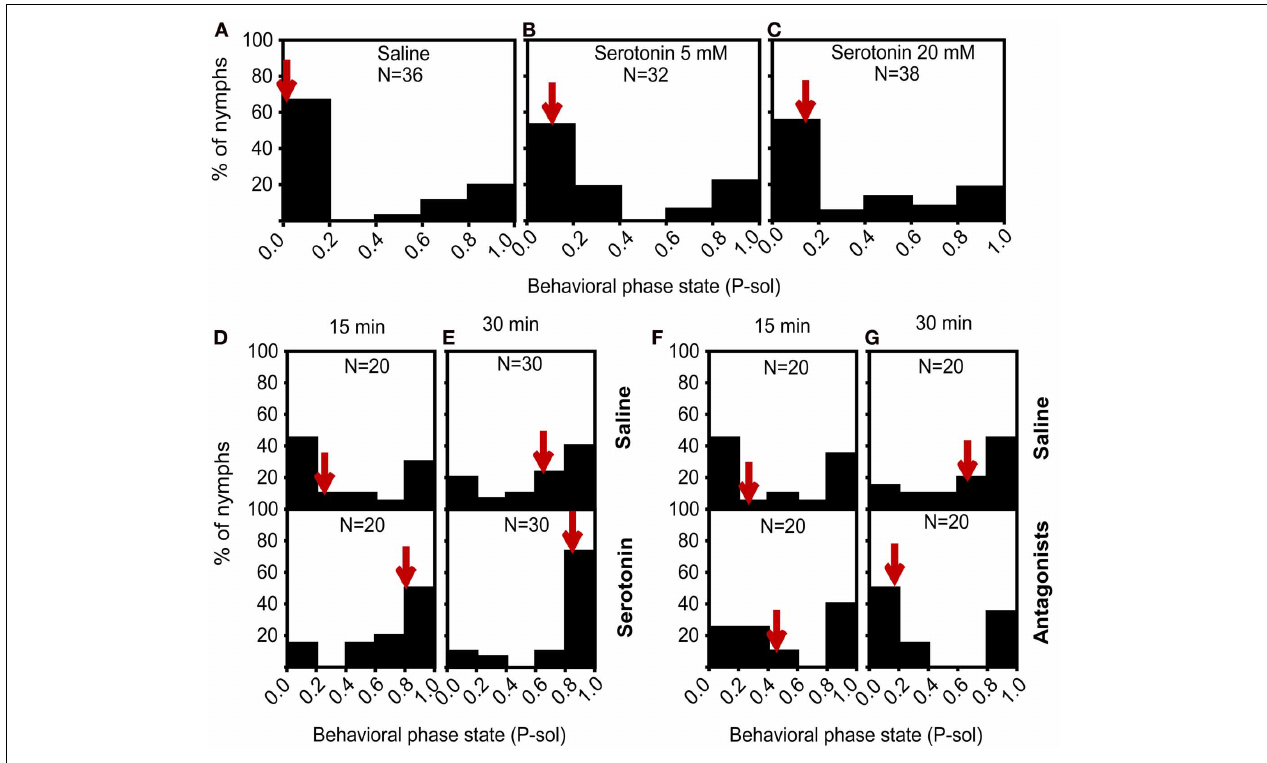
FIGURE 5 | Behavioral responses of gregarious nymphs after pharmacological intervention in serotonin signaling. (A–C) Effect of serotonin on the phase state of gregarious nymphs, saline (A) , 5mM (B) , and 20mM (C) . (D,E) Effect of serotonin on the phase state of gregarious